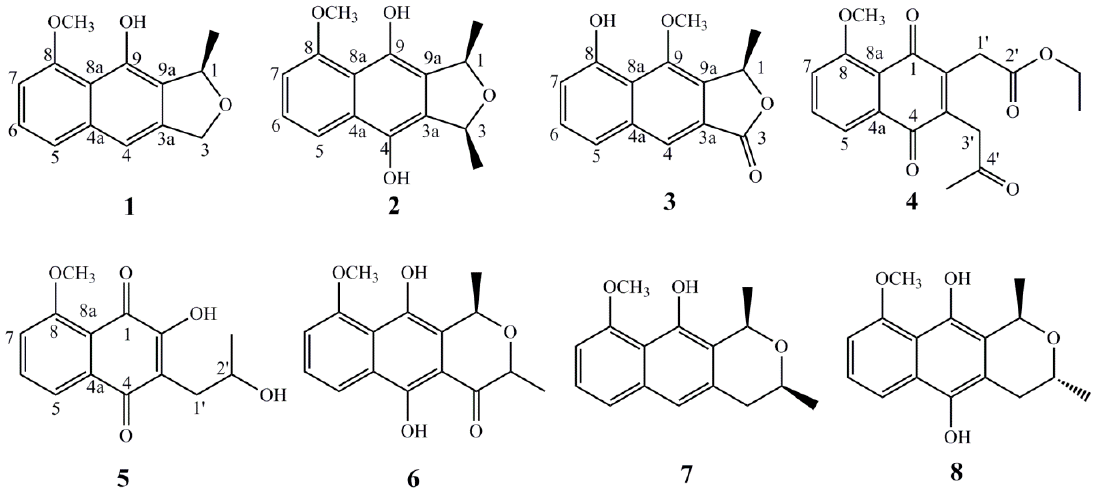
Figure 1. Structures of compounds 1 – 8 .